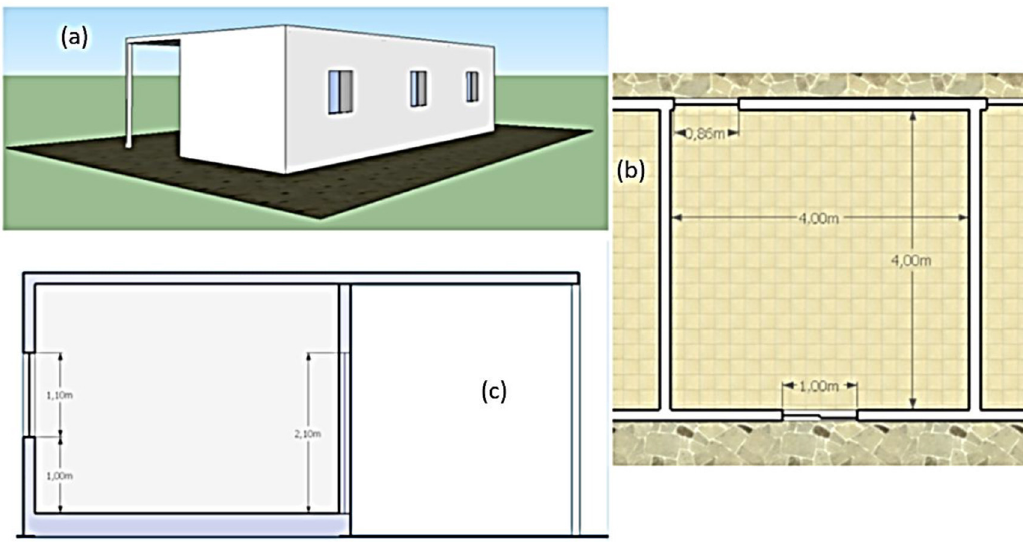
Fig. 2. Perspective (a), Floor plan (b) and Section (c) of the reference model with